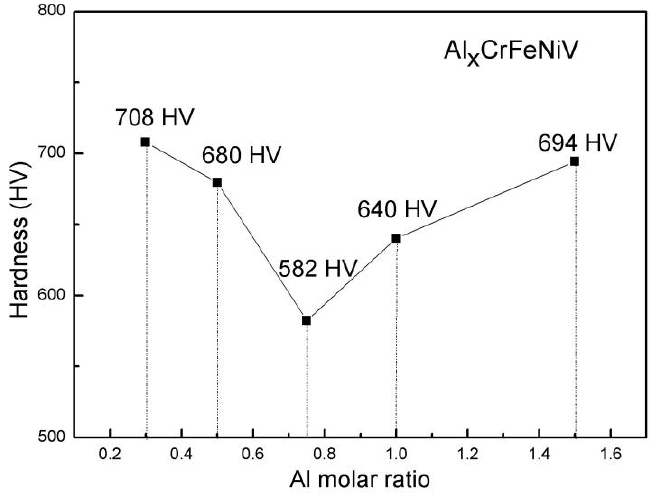
Figure 6. SEM images of fracture surfaces of: ( a ) Al 0.3 CrFeNiV; and ( b ) Al 0.5 CrFeNiV alloys following the compression deformation at room temperature; the yellow arrows indicate the microcracks.